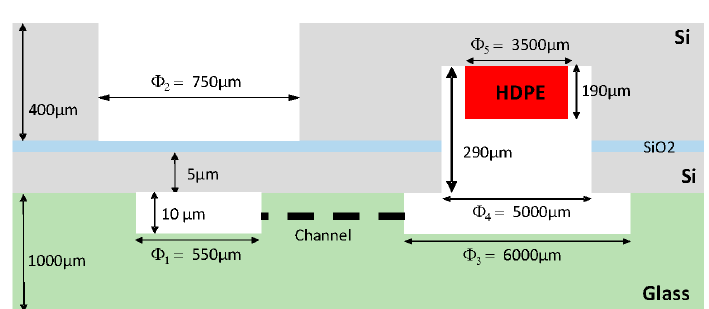
Figure 3. Cross section of the prototype for the measurement of G H2